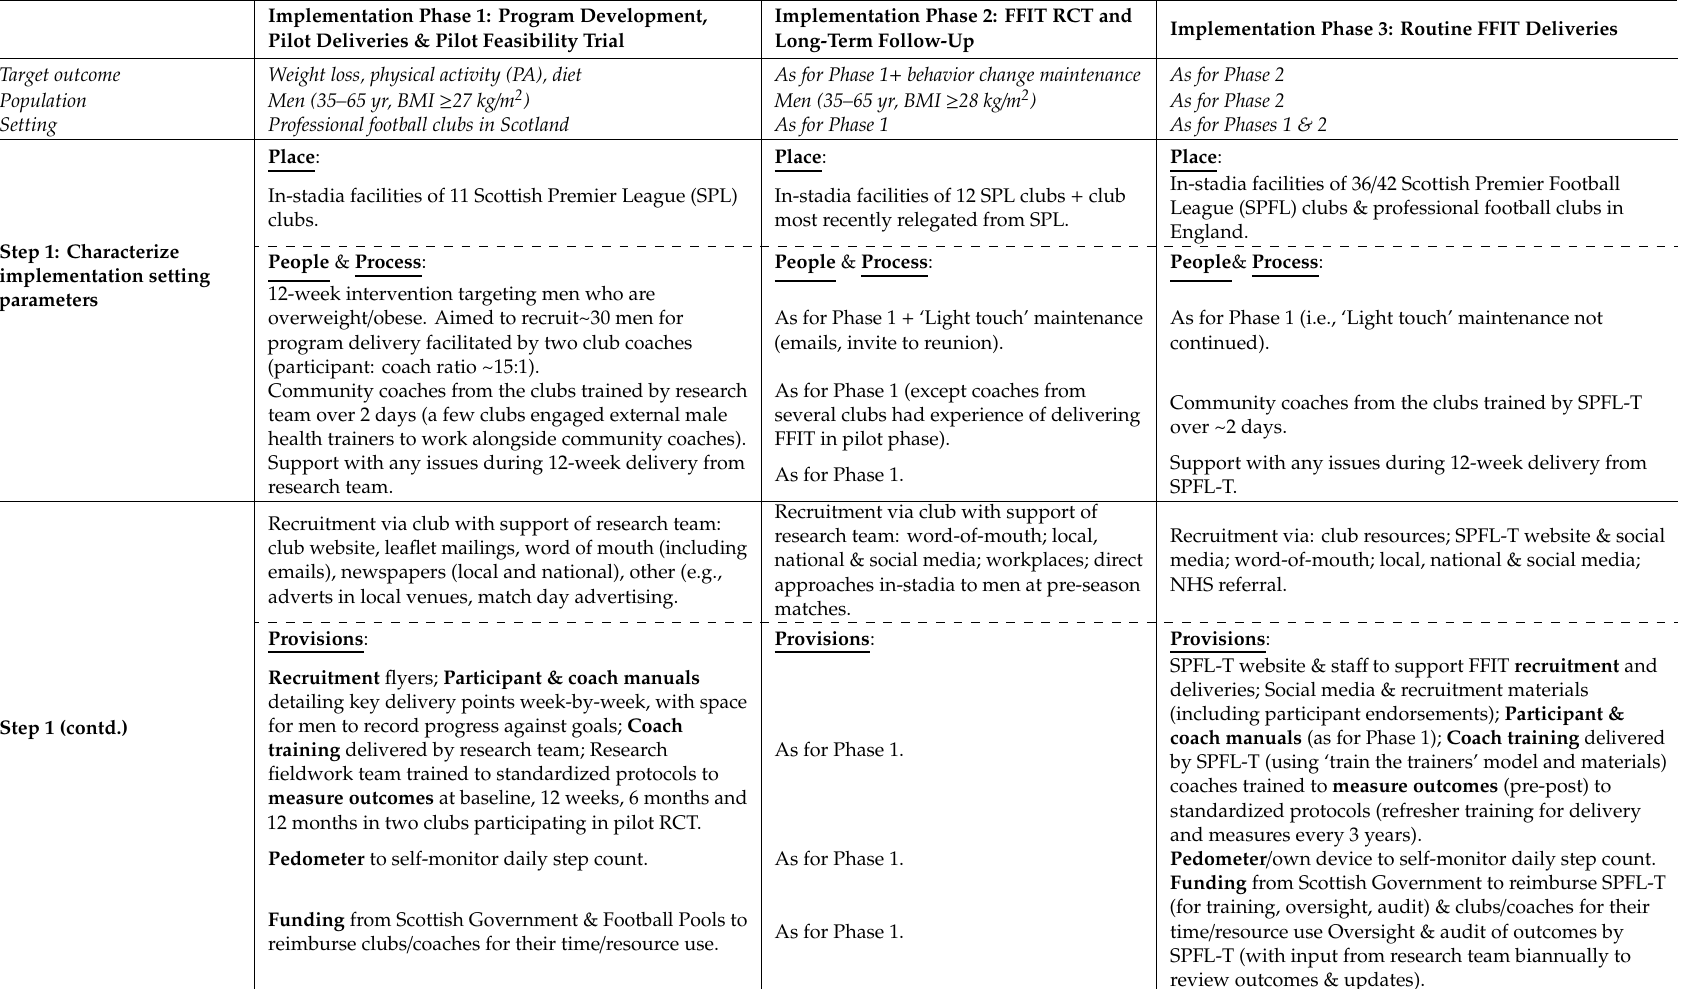
Table 1. FFIT development, evaluation and scale-up mapped onto the ‘5Ps’ (Place, People & Process, Provisions, Principles) and Steps 1–4 of the PRACTIS guide. Implementation Phase 1: Program Development, Implementation Phase 2: FFIT RCT and Pilot Deliveries & Pilot Feasibility Trial Long-Term